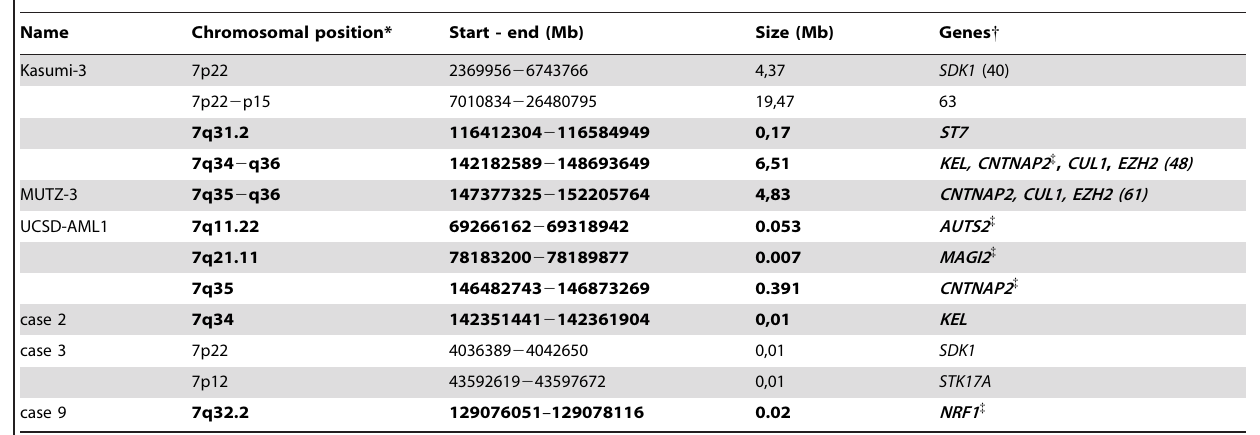
Table 3. Array CGH results of chromosome 7 deletions.